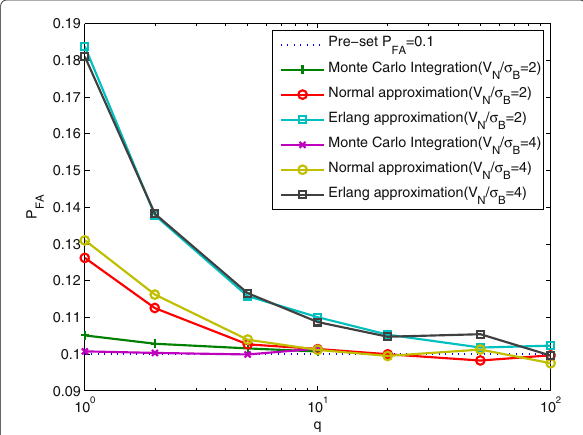
Fig. 6 Comparison of the joint PDF approximation tests showing the bias in P FA due to the joint PDF approximation (Erlang approximation and Normal approximation to (27)) applied to (26), when the empirical histogram obtained from Monte Caro integration is taken as